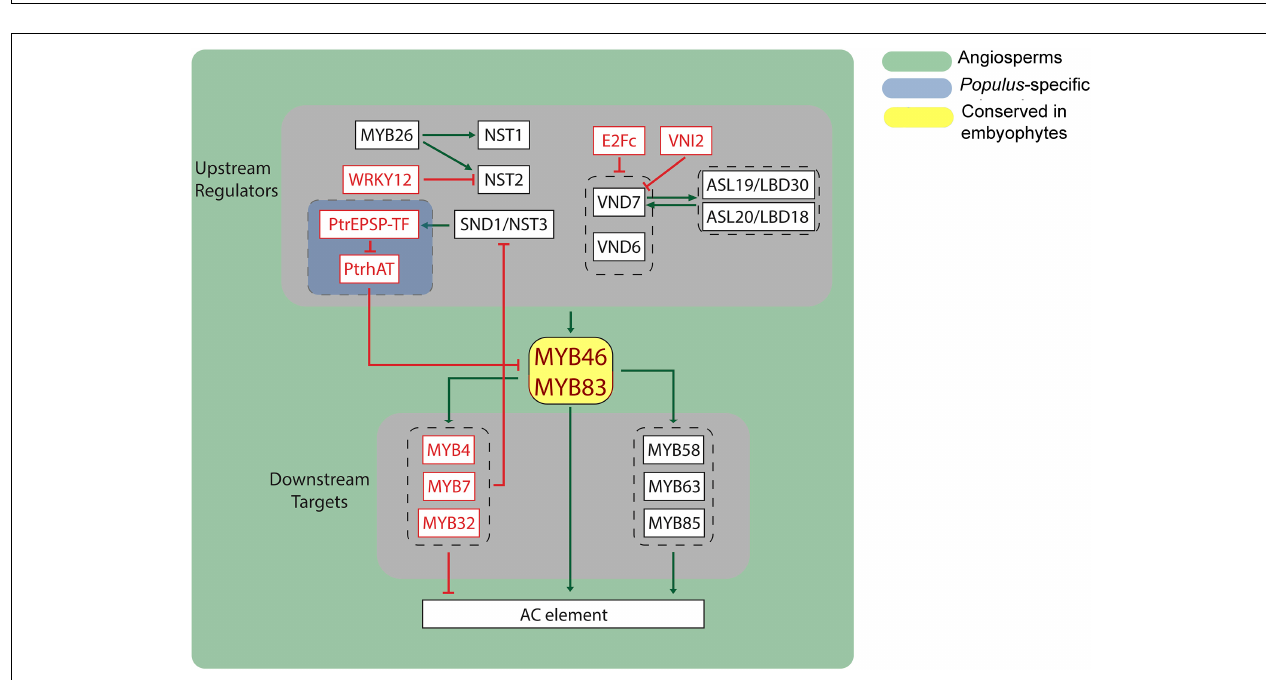
FIGURE 2 | Transcriptional network of lignin biosynthesis in plants. Black box indicates transcriptional activator, and red box indicates transcriptional repressor. Green arrows indicate transcriptional activation, and red blunt arrows indicate transcriptional repression. AC element, recognized by MYBs, were found in most of lignin biosynthetic